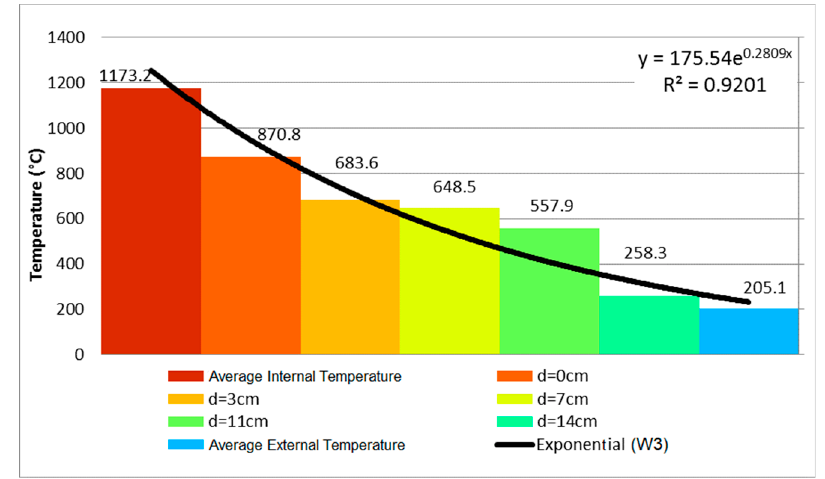
Figure 10. Temperature profile at 240 min—P3.